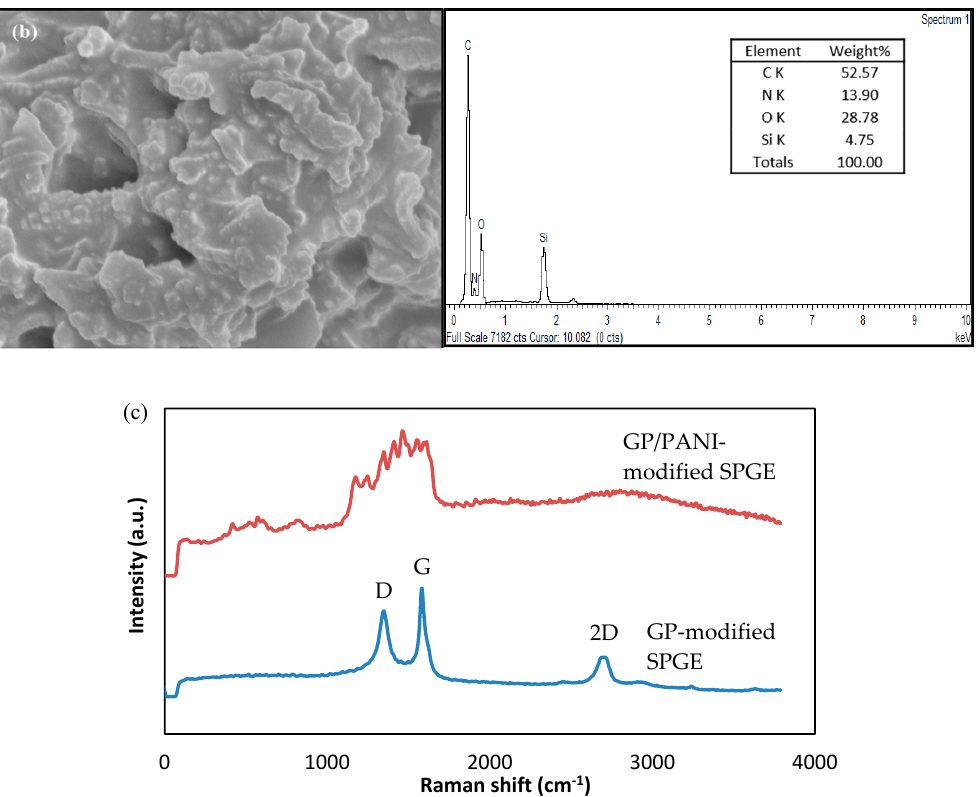
Figure 3. FESEM images coupled with EDX spectra of ( a ) bare SPGE and ( b ) GP/PANI-modified SPGE. ( c ) Raman spectra of GP-modified SPGE and GP/PANI-modified SPGE.